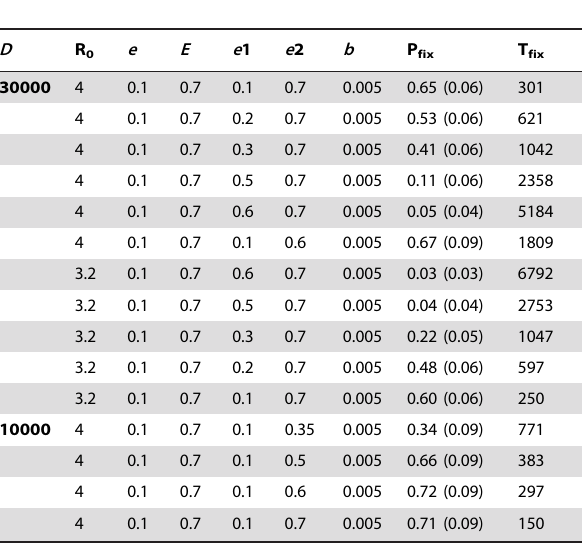
Fixed parameters were N d =5 and U =0.0001.